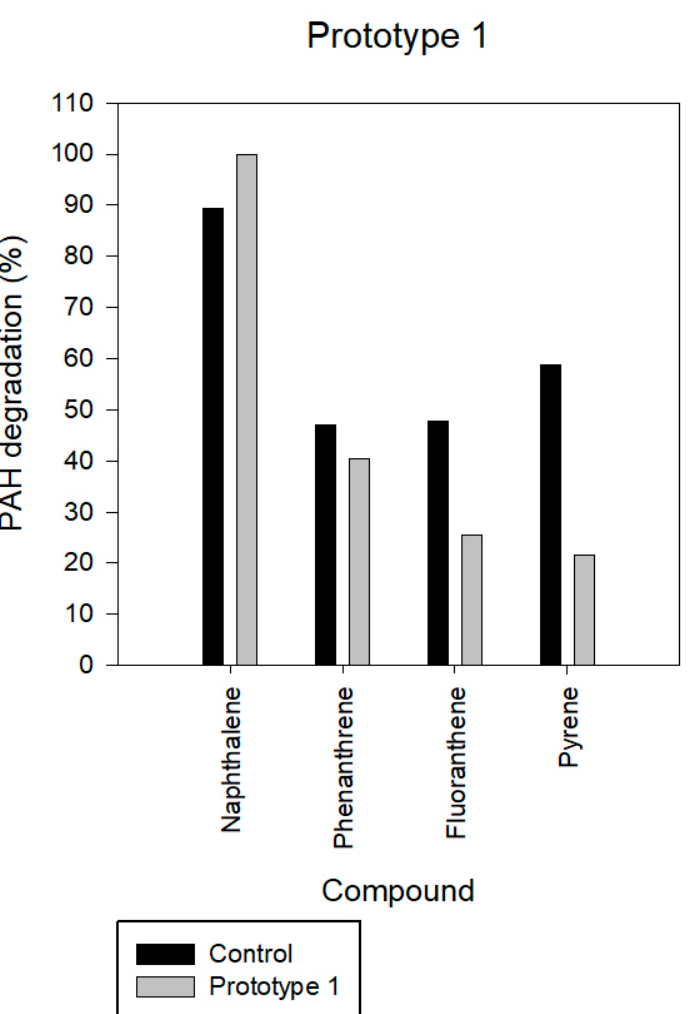
Figure 4. Polycyclic aromatic hydrocarbon (PAH) degradation (%) using prototype 1 versus the control system after 74 days. n = 1.